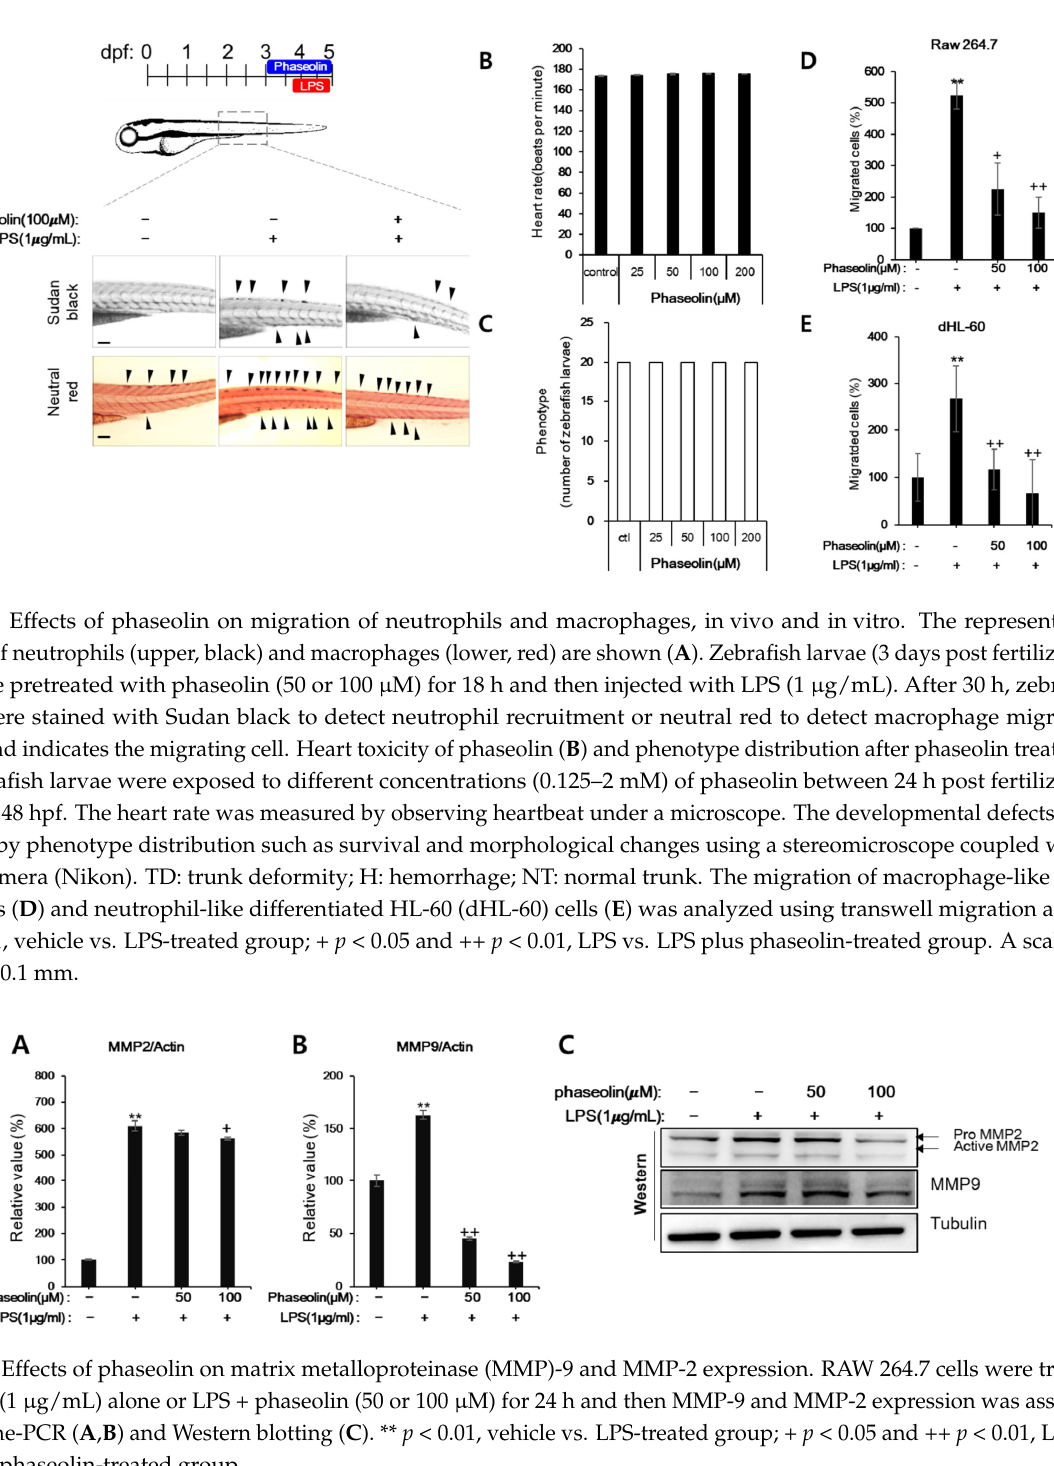
Figure 7. Effects of phaseolin on nuclear NF- κ B translocation and inhibitor kappa B (I- κ B) degradation. RAW 264.7 cells were treated with LPS (1 μ g/mL) alone or LPS + phaseolin (50 or 100 μ M) for 24 h and then the expression levels of nuclear NF- κ B and cytoplasmic I- κ B were assessed using Western blotting ( A ) and immunofluorescence staining of NF- κ B ( B , green). Nuclei were stained with 1 μ g/mL DAPI (blue). A scale bar indicates 10 μ m. 3.6. Phaseolin Attenuated Endotoxin-Induced Uveitis in Mice Next, we examined whether phaseolin exhibited anti-inflammatory effect in vivo, we used the endotoxin-induced uveitis mouse model, in which phaseolin was treated after LPS stimulation. As previously reported, LPS increased the recruitment of Ninj1-express- ing macrophages into the retina. Phaseolin notably attenuated the increase of cell infiltra- tion that was increased by LPS stimulation (Figure 8A). In order to further confirm the inhibitory effects of phaseolin on LPS-induced inflammation, the protein levels of TNF- α , IL-6, and IL-10 were analyzed. As expected, phaseolin reduced the increase in IL-6 and TNF- α that was induced by endotoxin and increased the expression level of IL-10 (Figure